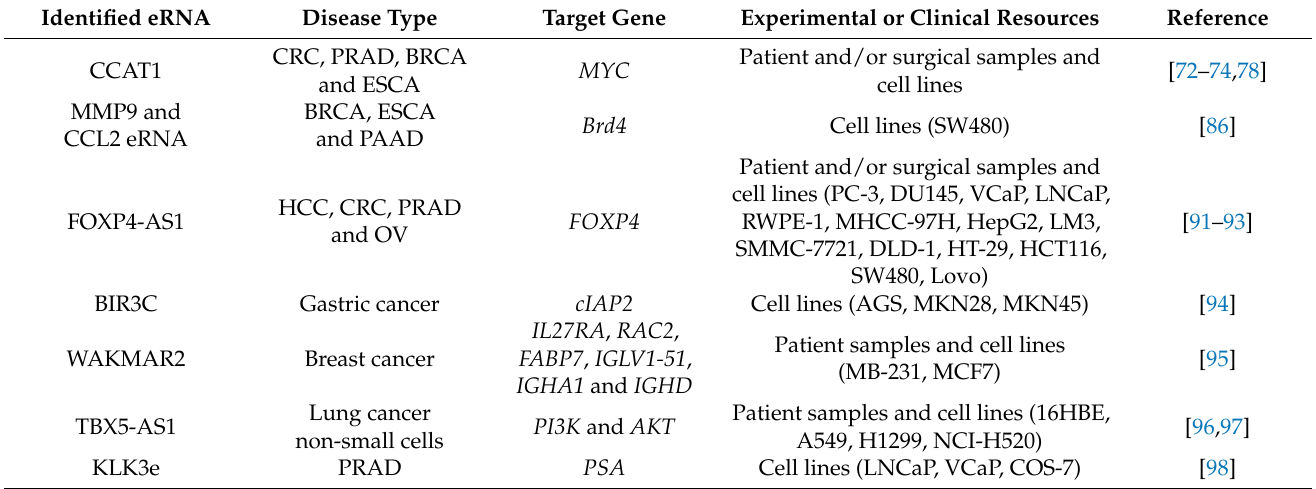
Table 1. Detectable eRNAs, targets and experimental or clinical resources in different human